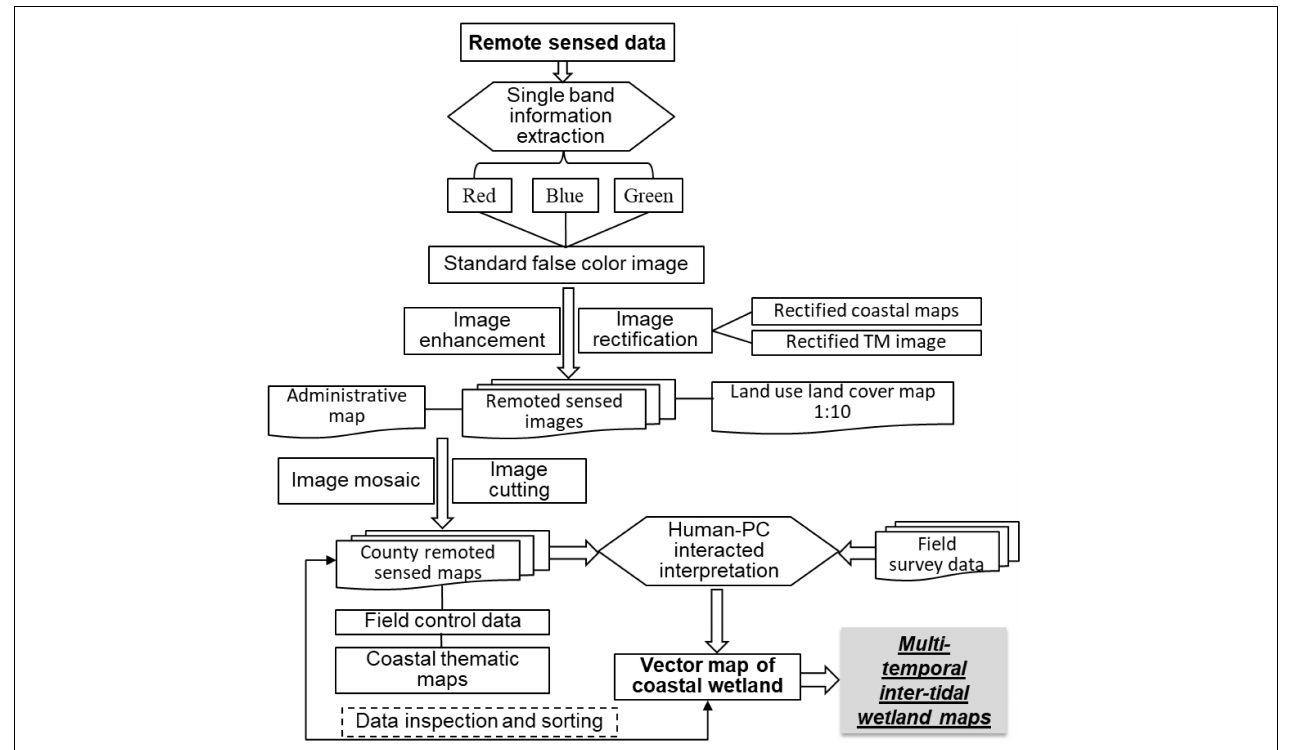
FIGURE 3 | Image interpretation